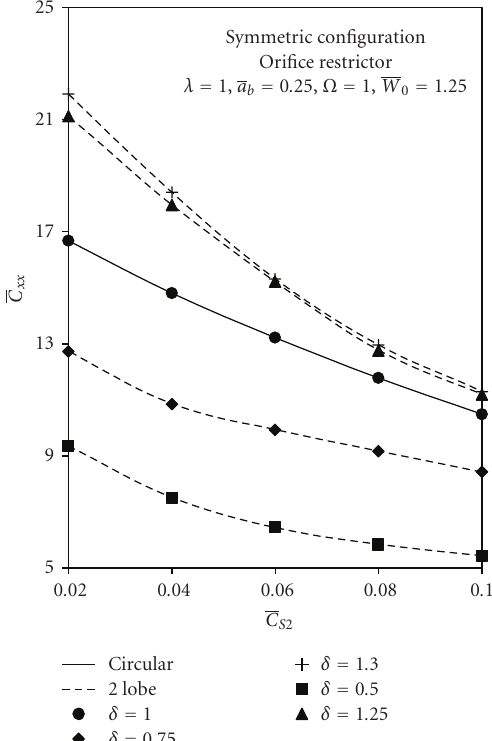
Figure 11: Variation of direct damping ( C xx